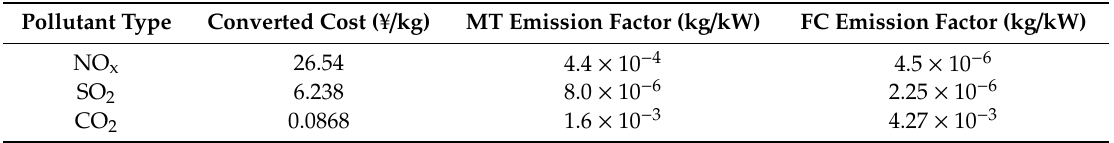
Table 3. Conversion cost of pollutants and emission factors. Micro-turbine (MT): kg / kW; Full Cell(FC): kg / kW.